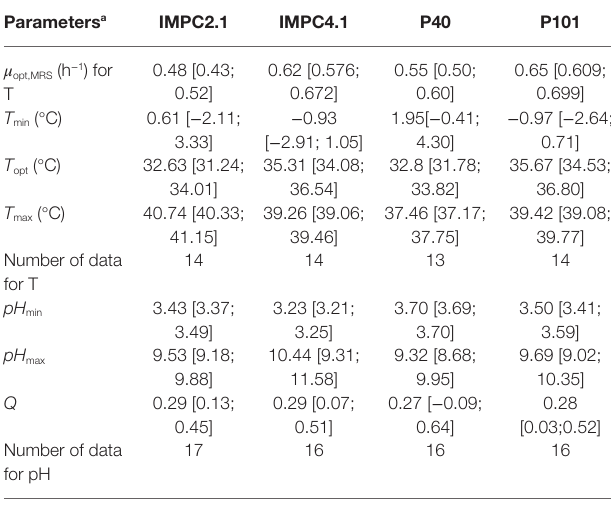
TABLE 2 | Estimated growth cardinal parameters and 95% CI for the Lacticaseibacillus paracasei strains. Parameters